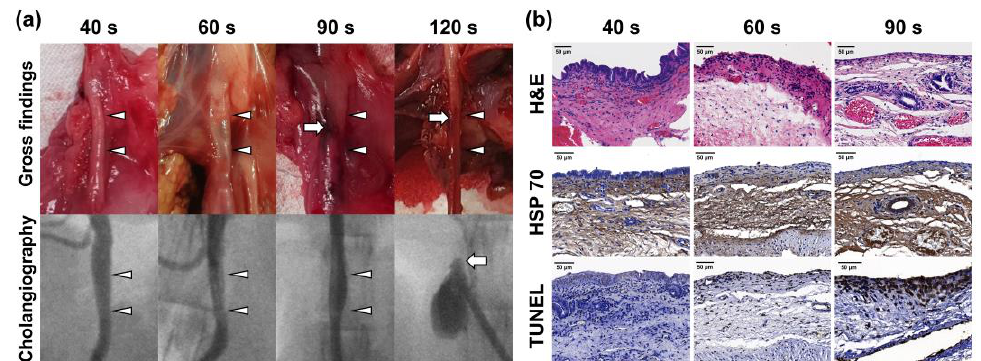
Figure 3. Gross, cholangiography, histological, and immunohistochemistry findings immediately after RF ablation for 40, 60, 90, and 120 s at 70 °C. ( a ) Gross and cholangiography findings confirmed that the damage in the bile duct worsened over time. ( b ) As the duration of ablation was increased, submucosal thickness decreased, thermal damage worsened, and cell death increased.